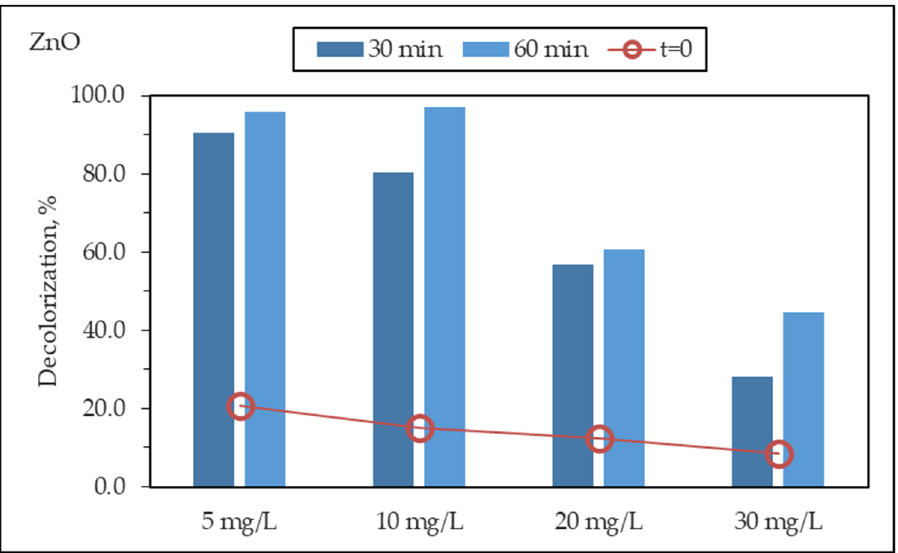
Figure 14. Photocatalytic degradation of MB upon use of sole ZnO: Initial MB concentration effect.